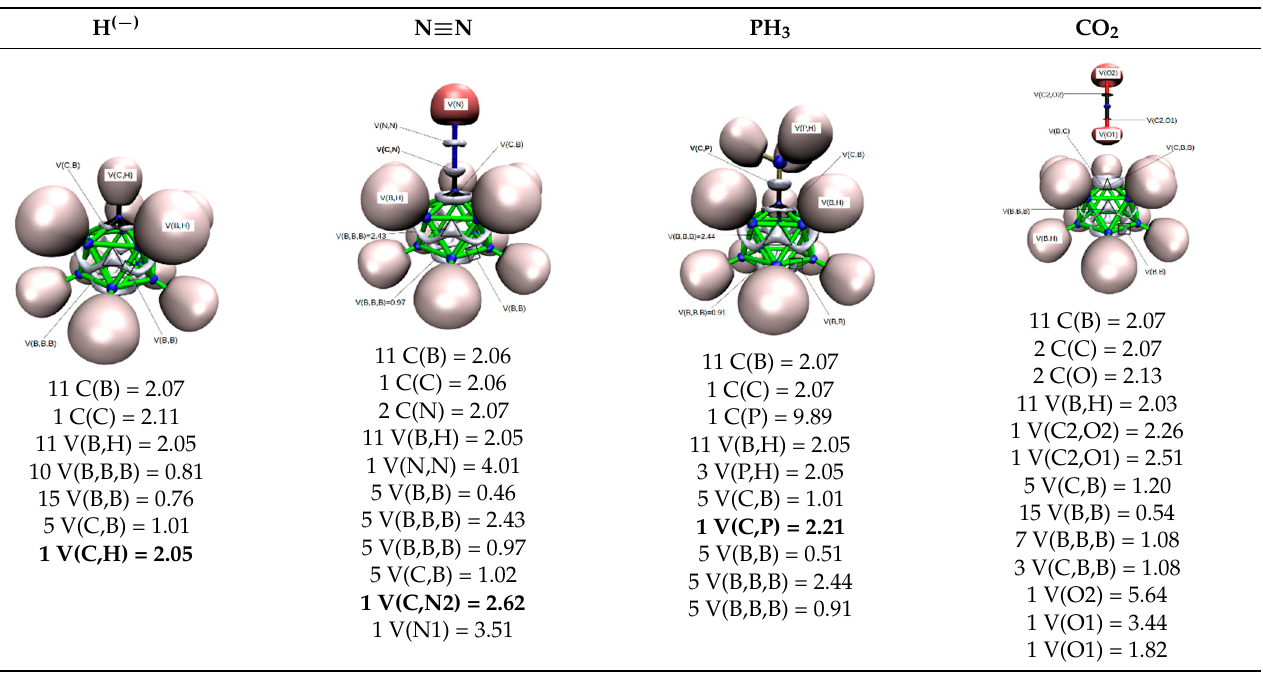
Table 2. Electron localisation function (ELF) (isovalue 0.83 au) for complexes H 11 B 11 C:H ( − ) → ( 1 : 2 ), H 11 B 11 C:N ≡ N → ( 1 : 6 ), H 11 B 11 C:PH 3 → ( 1 : 17 ), and H 11 B 11 C:O=C=O → ( 1 : 13 ). Basin labels are depicted for each complex. Population of ELF disynaptic basins V(C, X) in